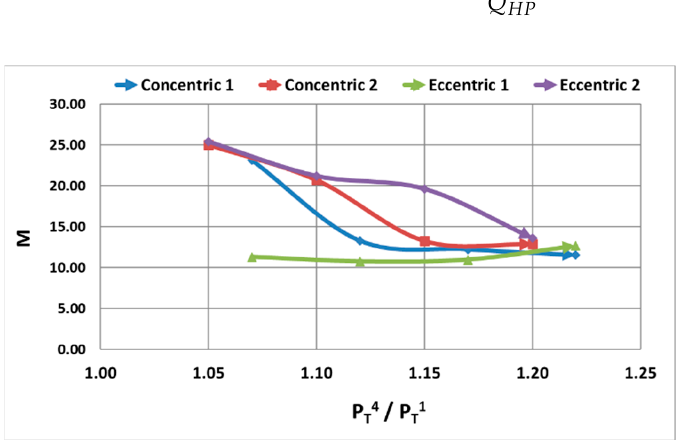
Figure 22. Driving fluid on the jet pump vs. pressure ratio.